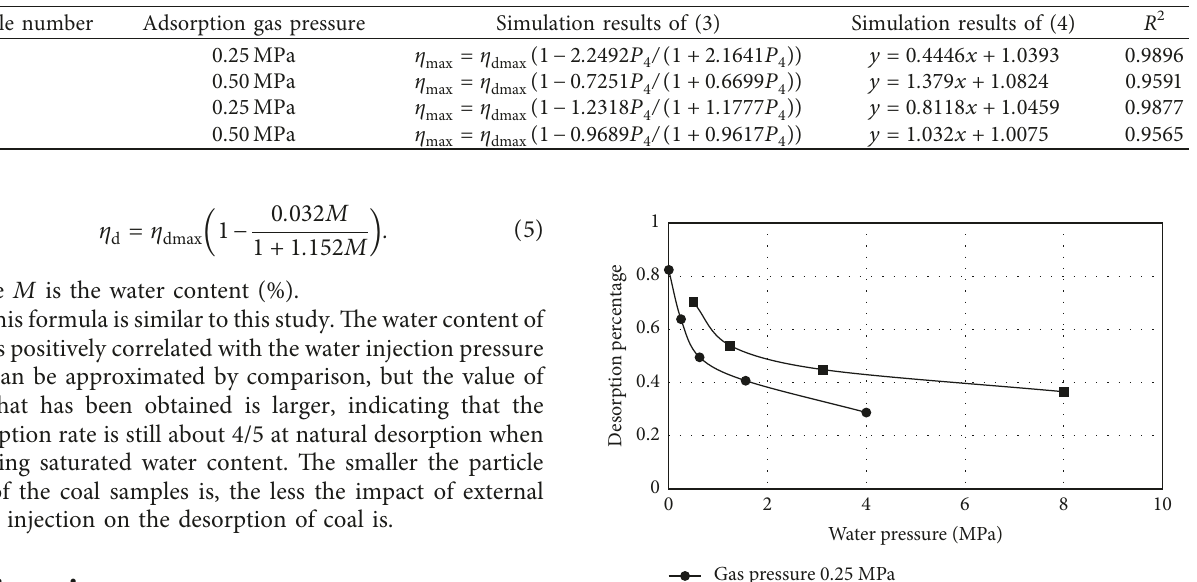
Table 5: Simulation results between desorption percentage and water injection pressure.